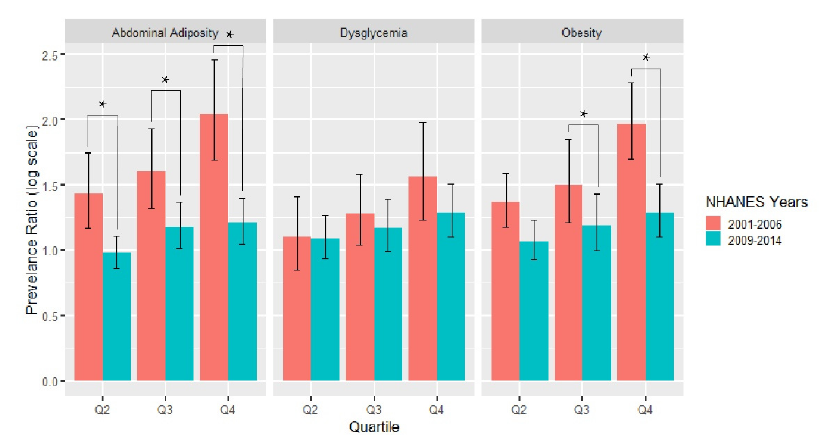
Figure 2. Adjusted prevalence ratio of cardiometabolic risk factors by subsidy score quartile in the